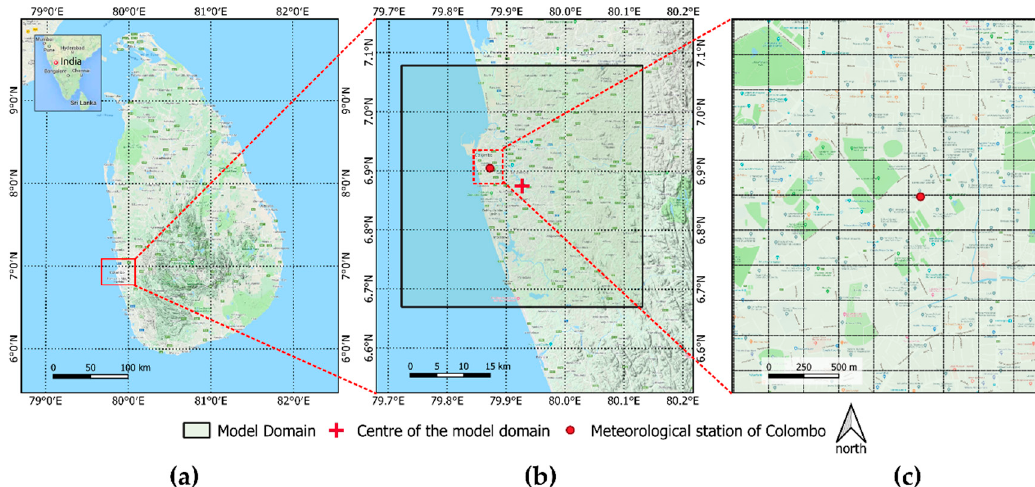
Figure 1. The location of the study. ( a ) Sri Lanka (Source: Google maps https://goo.gl/9WypnH); ( b ) model domain covered with 181 × 181 grid cells of 250 m × 250 m size (grid cells are two dense to show on the figure); ( c ) The actual grid cells (250 m × 250 m) around the location of the meteorological station.